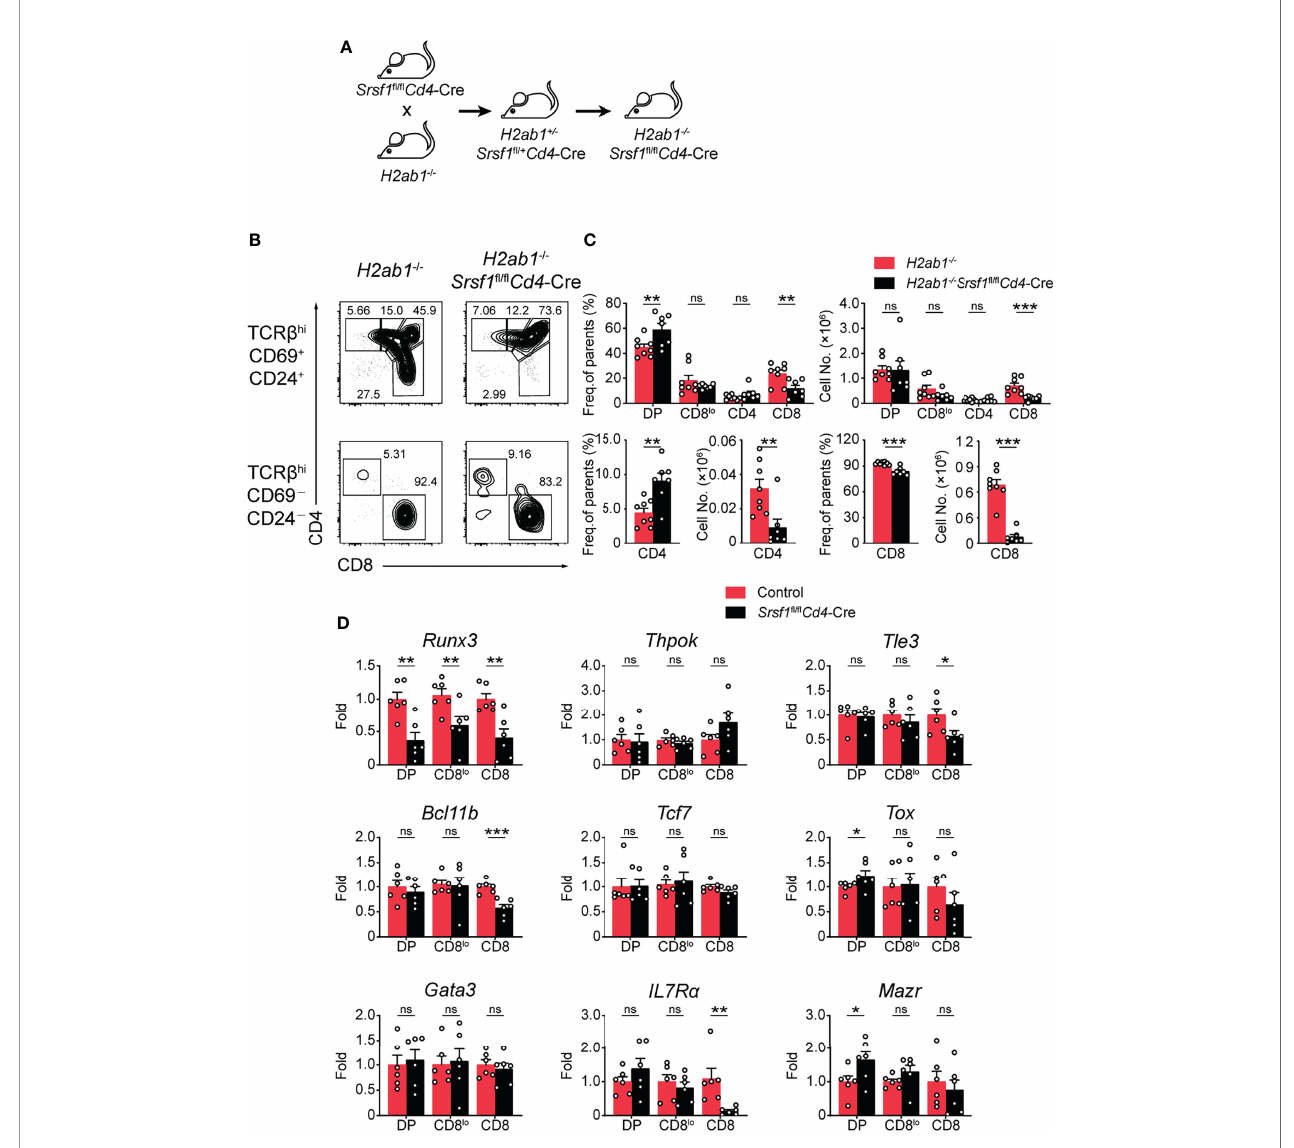
FIGURE 5 | SRSF1 is involved in the lineage selection of CD4-versus-CD8 T cells. (A) The scheme shows the generation of H2ab1 -/- Srsf1 fl / fl Cd4 -Cre mice. (B, C) Analysis of the post-selection TCR b hi thymocytes from H2ab1 -/- Srsf1 fl / fl Cd4 -Cre mice. The immature (TCR b hi CD69 + CD24 + ) subsets were subdivided into CD4 + , CD4 + CD8 lo , DP, and CD8 + sub-populations (clockwise from left in top row), and the mature (TCR b hi CD69 − CD24 − ) subsets were further subdivided into CD4 + and CD8 + populations (bottom row). The frequency and numbers of indicated subsets were shown in (C) , respectively (n ≥ 6). (D) Analyzing the expression of Runx3 , Thpo k ( Zbtb7b ), Tle3, Bcl11b, Tcf7, Tox, Gata3, IL7R a and Mazr in immature TCR b + DP, CD4 + CD8 lo , and mature CD8 + SP thymocytes from Control or Srsf1 fl / fl Cd4 -Cre mice. The relative expression of Srsf1 transcript in indicated T cell subsets (after normalization to Gapdh ) in Control cells was set as 1, and its relative expression in cells from Srsf1 fl / fl Cd4 -Cre mice was normalized, accordingly. Data were collected from at least two independent experiments. The error bars are means ± SD. Statistical signi fi cance was determined by one-tailed Student ’ s t -test. ns, not statistically signi fi cant; *P < 0.05 , **P < 0.01 , and ***P < 0.001